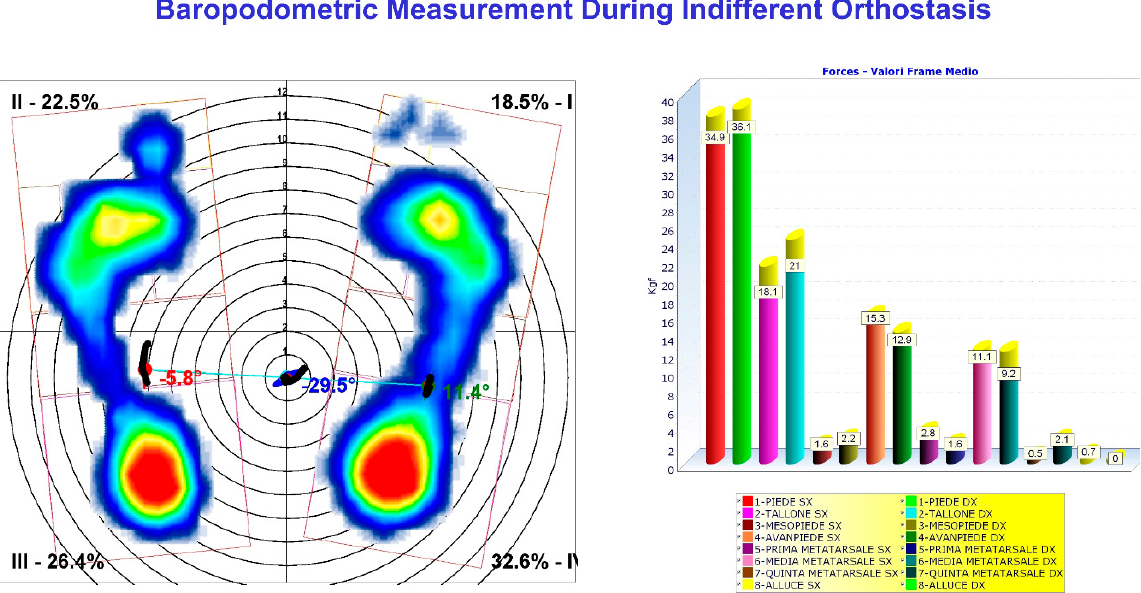
Figure 4. Standard biomechanical reports of the patient’s 3D (averaged) posture and spine shape measured in three different standing conditions: IO (panel a ), SCO (panel b ) and WCO (panel c ), respectively. The end and apical vertebrae (depicted in blue and red colours respectively), Cobb, kyphosis and lordosis angle values, and the spinal and global offset values and their averages, are automatically identified and computed (the horizontal distances in the frontal and sagittal planes of each labelled spine landmark respect to the vertical axis passing by S3 are defined as spinal offsets, while the horizontal distances in the frontal and sagittal planes of each labelled spine landmark respect to the vertical axis passing through the middle point between heels are defined as global offsets; such values are averaged to compute the average spinal and average global offsets as summarising value; negative values represent offsets on the left side in the frontal plane and forward offsets in the sagittal plane). A leg-length discrepancy (being the left leg longer than the right one) was determined in IO. It was associated with spine deformities and postural unbalancing with a lateral-leaning posture on the right side either globally or in the trunk. In WCO, it is possible to evaluate the effects induced by the LLD compensation through an underfoot wedge of 20 mm. The pelvis horizontal alignment was restored, global and spinal offsets reduced to almost zero value and spinal deformities strongly reduced in value.